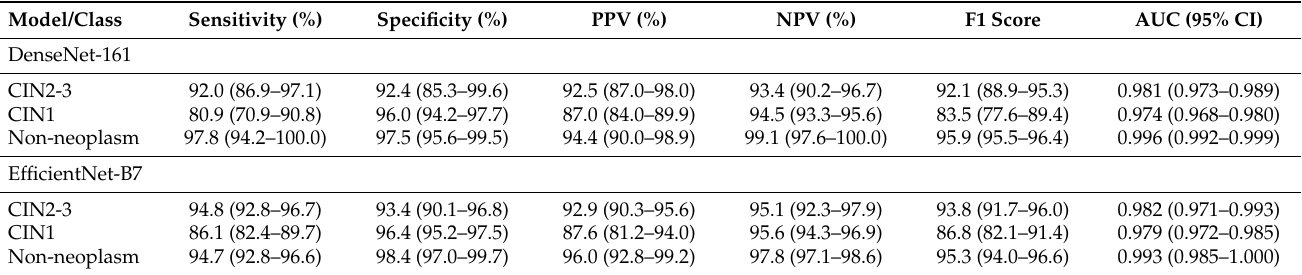
Table 3. Per-class performances of the deep learning models in the three-class classification.